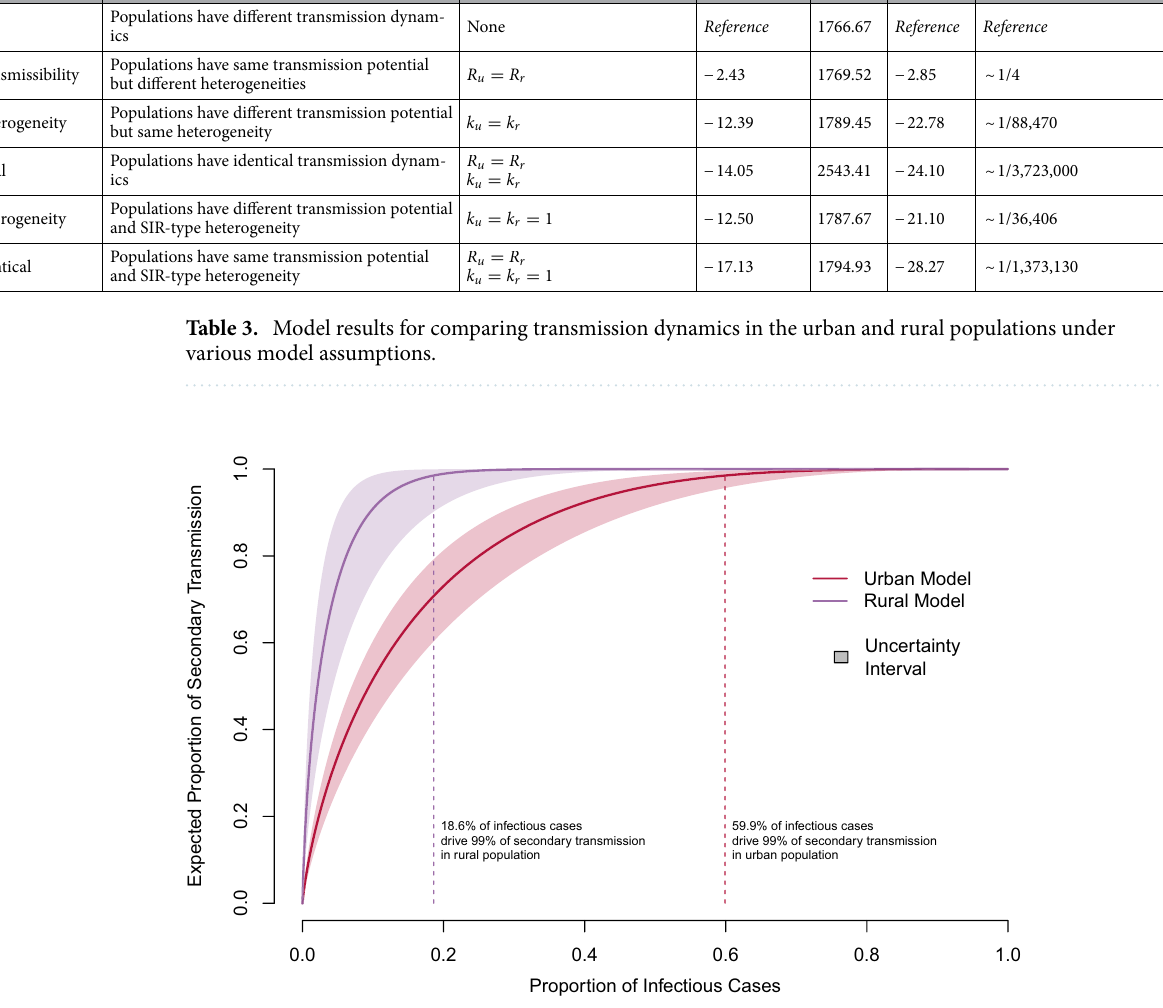
Figure 5. Expected proportion of TB transmission attributed to a given proportion of infectious cases, by population. The proportion of cases responsible for 99 percent of transmission in each model is denoted by the vertical dotted line. The uncertainty interval integrates across the entire range of 95% confidence intervals for ˆ ˆ k R and both